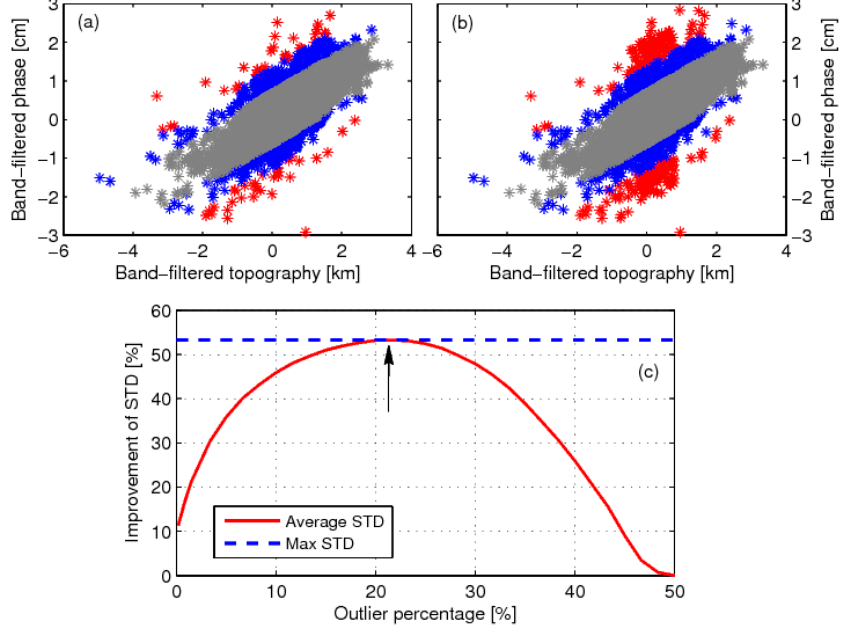
Figure 9. Examples to test the effectiveness of robust estimation. ( a ) Outlier rejection results of robust estimation for the original band-filtered data obtained from interferogram 20081025/20081129 in California. ( b ) Results of robust estimation for the original band-filtered data with extra simulated